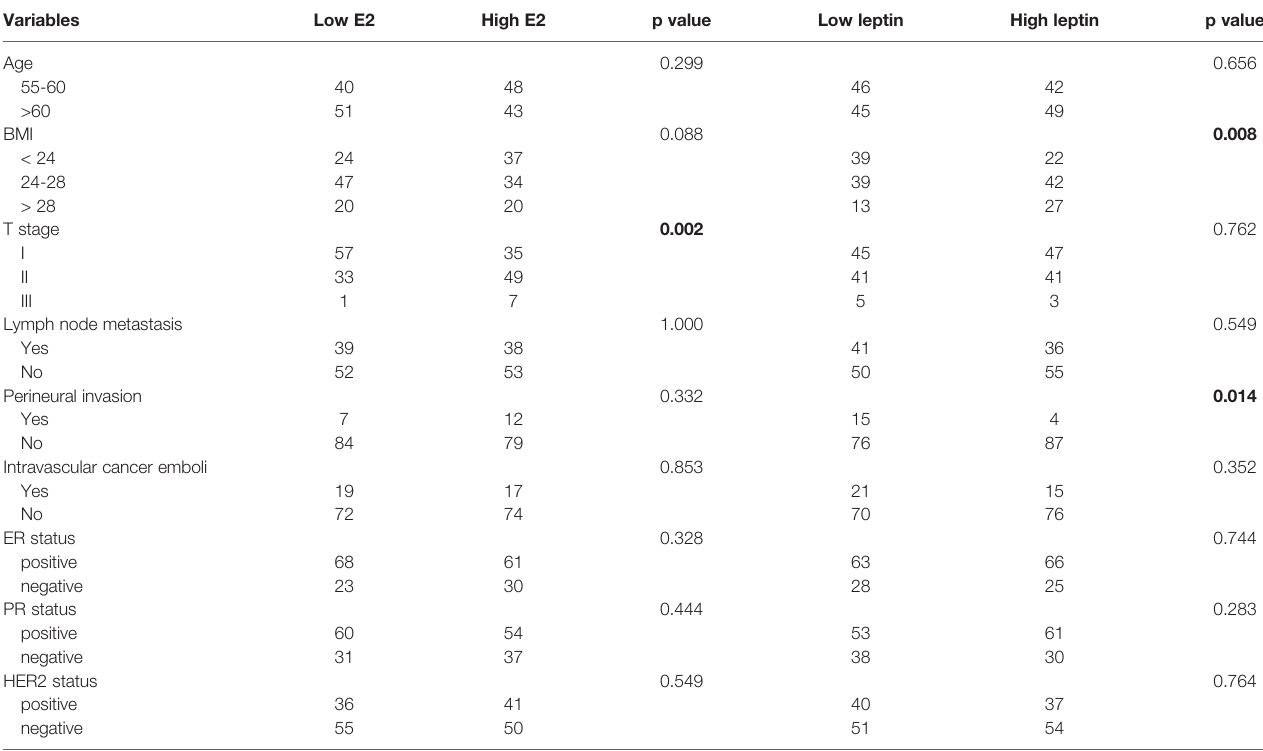
TABLE 2 | Relationship between E2 and clinicopathological factors of elderly breast cancer patients.